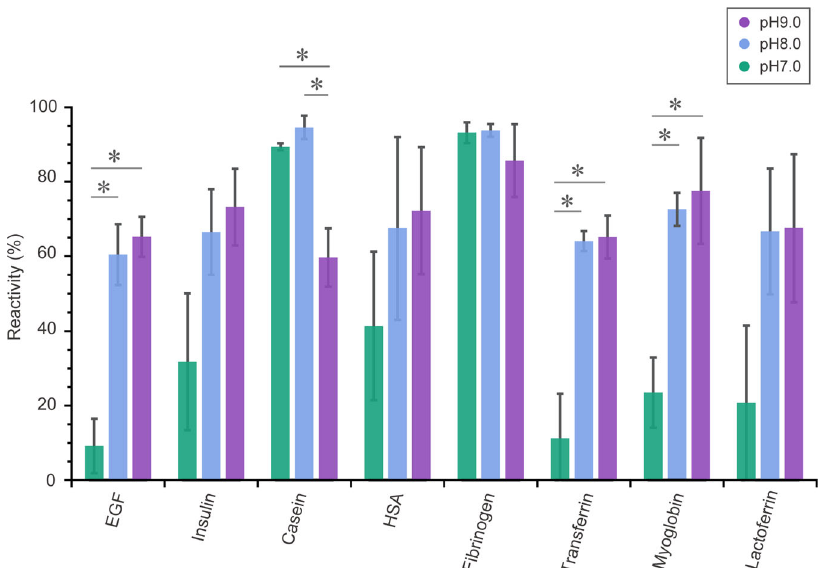
Fig. 3 MTG-catalyzed conjugation of LinkCFQ to substrate proteins with pI values of 4.78 – 8.34 at different pH values (pH 7, 8, and 9). The reaction was evaluated via sodium dodecyl sulfate – polyacrylamide gel electrophoresis, followed by staining with Coomassie brilliant blue (Supplementary Fig. 4). Reactivity (%) was de fi ned and calculated using Eq. 3. All error bars represent standard deviations. * P < 0.05.